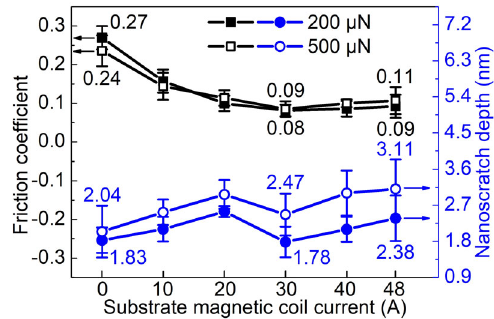
Fig. 9 Trends of the friction coefficient and nanoscratch depth with I s at loads of 200 and 500